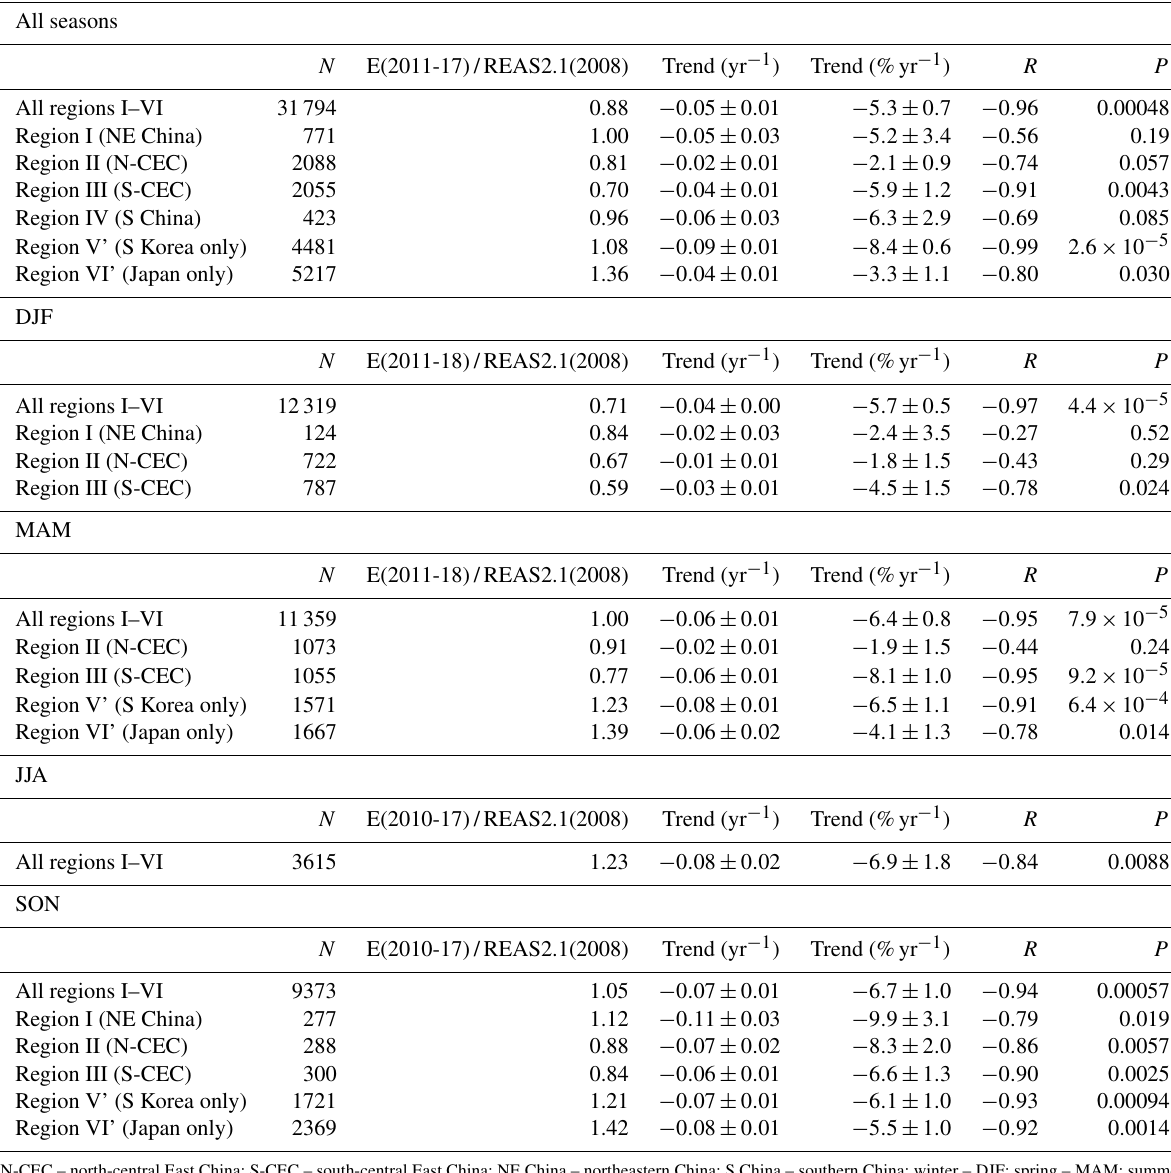
Table 2. Trends of estimated emissions of black carbon (BC) for all or in each of the seasons and for all regions (I–VI) and individual regions. The hourly data numbers ( N ), estimated emission ratios with respect to REAS2.1(2008), correlation coefficients regarding the year ( R ), and P values regarding the significance of the trend are also